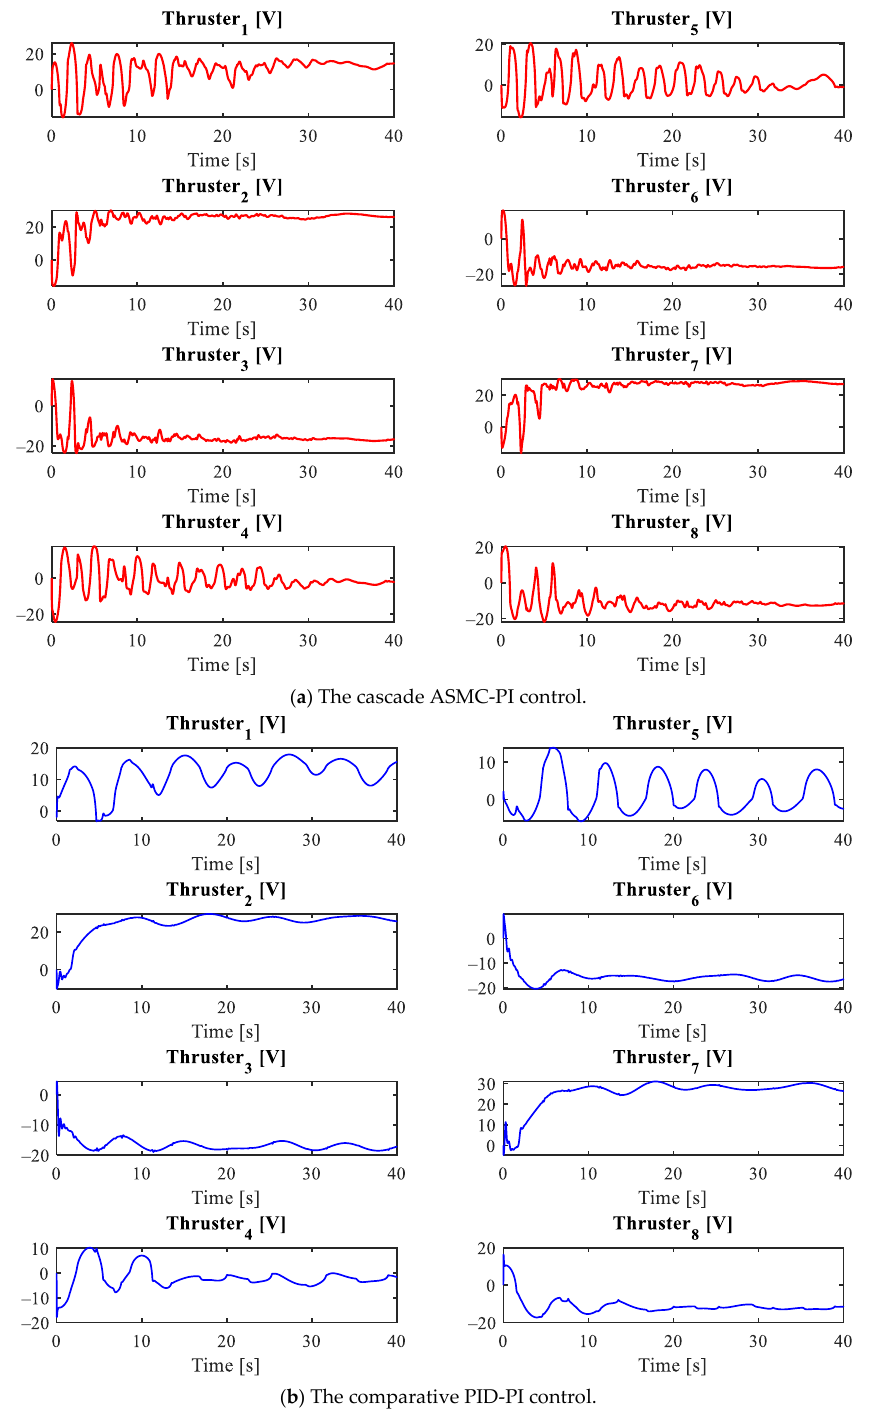
Figure 13. Control inputs of the ROV in the retrieving